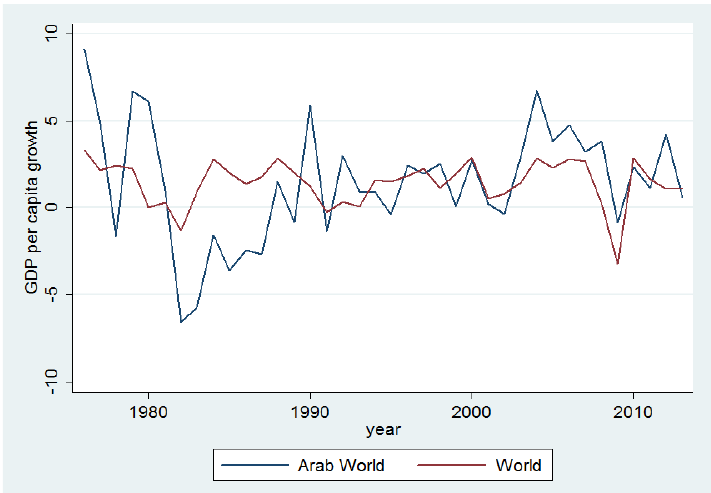
Figure 2: Per capita GDP growth in the Arab world